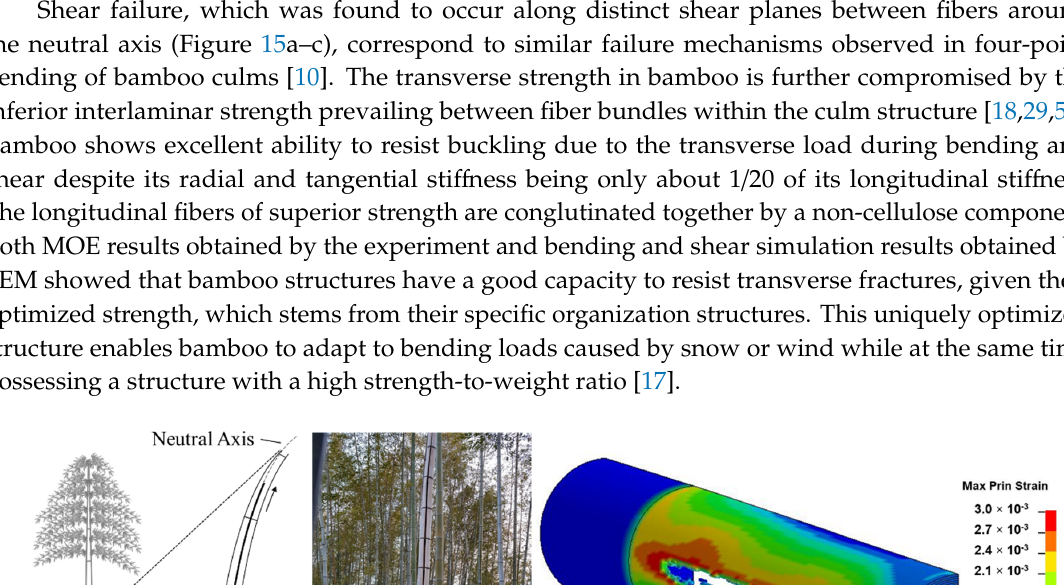
Figure 14. Failure mechanisms of bamboo in bending: ( a ) ovalization of internode cross-section as observed by FEM in bending mode; ( b ) transverse crack propagation originating from 4 vertices in cross-section due to compressive force induced during bending; ( c ) transverse crack propagation in cross-section as observed by FEM in bending mode.